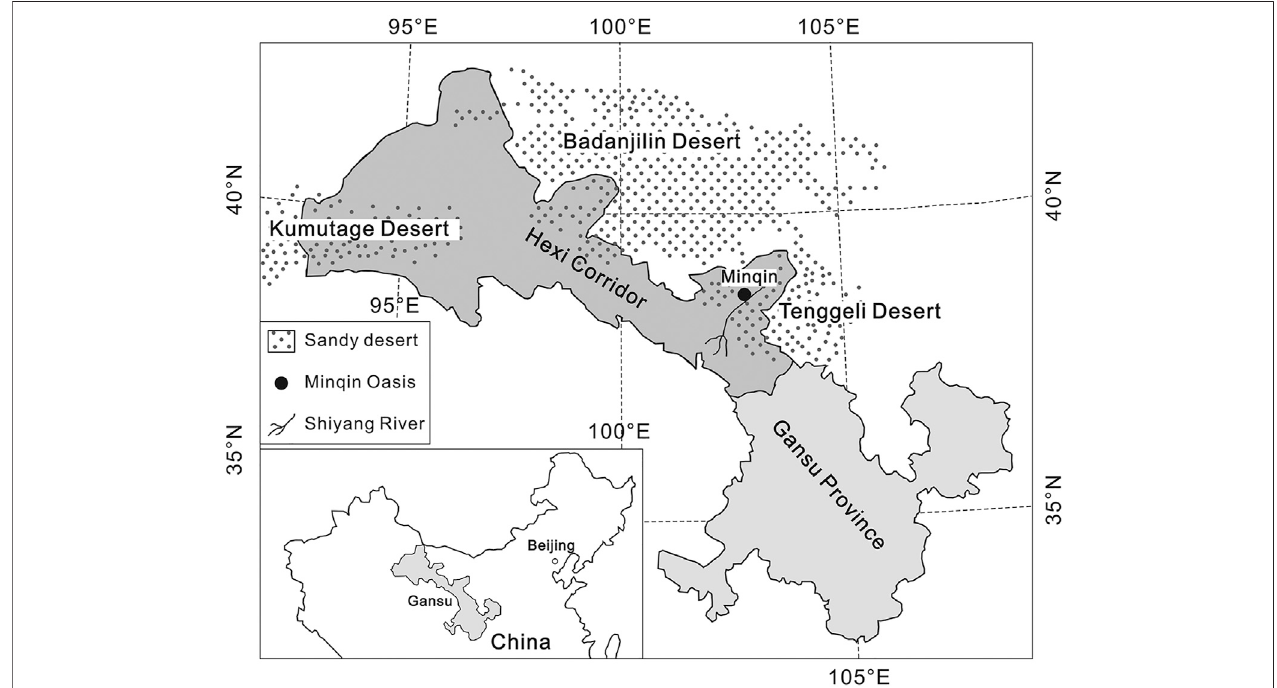
FIGURE 1 | Geographical position of the Hexi Corridor in China (the Hexi Corridor is located in the west of Gansu Province and is a part of Gansu Province).